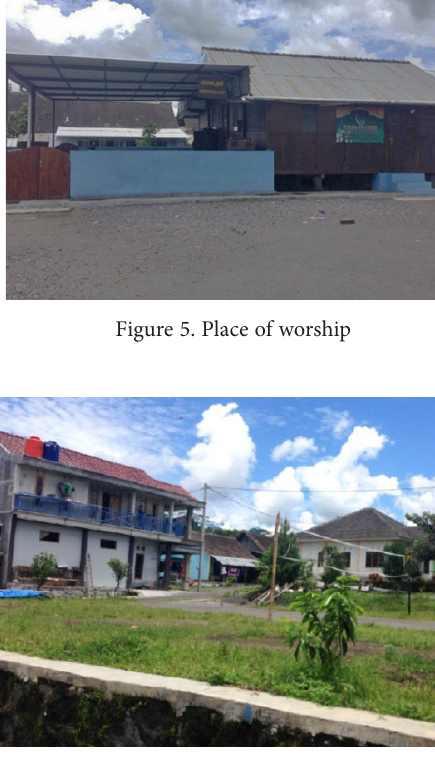
Figure 6. Sports